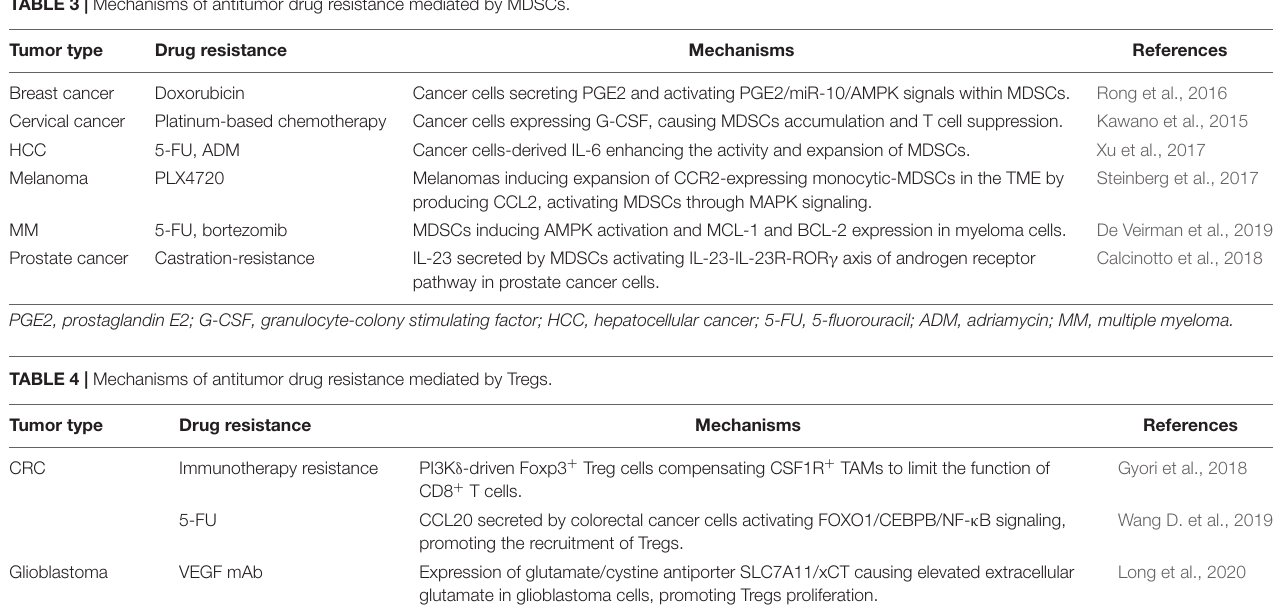
TABLE 3 | Mechanisms of antitumor drug resistance mediated by MDSCs.